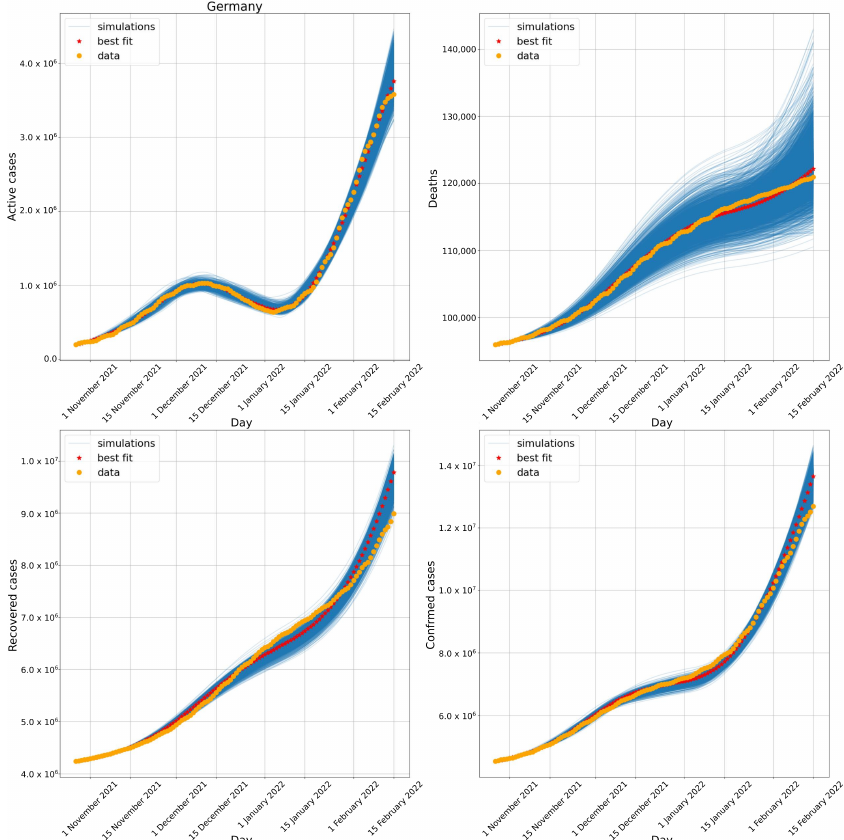
Figure 6. Evolution of the number of active cases ( upper left ), deaths ( upper right ), recovered cases ( lower left ), and confirmed cases ( lower right ) in Germany. All simulations with errors below 10% are